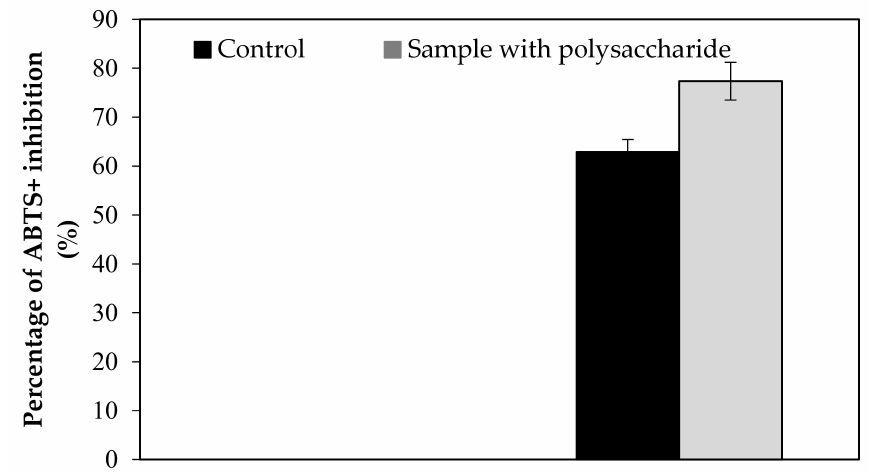
Figure A2. Effect of KWSP on ABTS+.